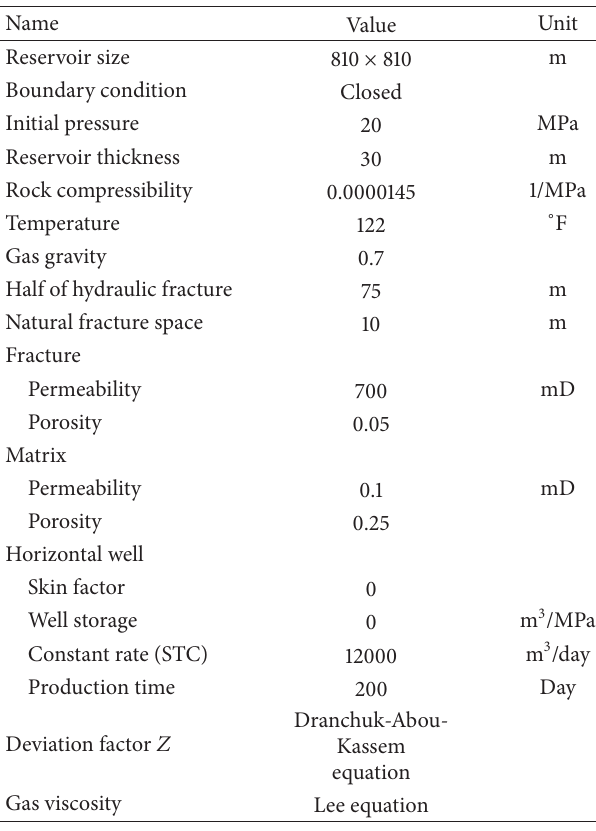
Table 1: Data used in validation.